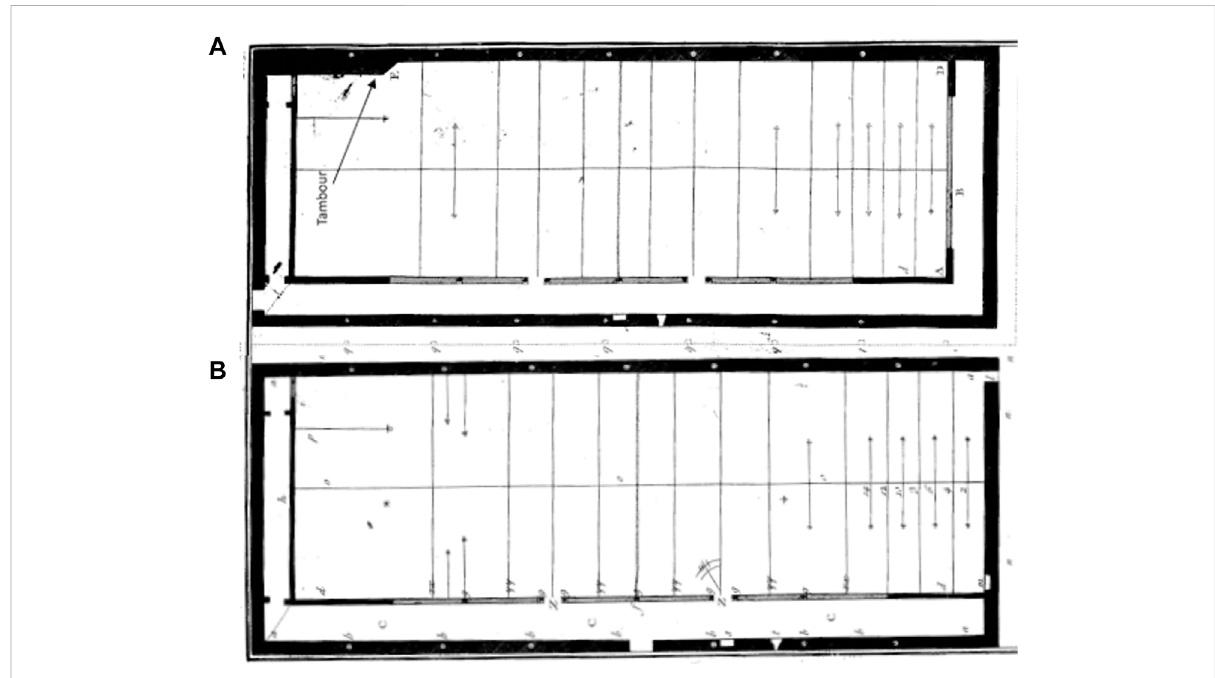
FIGURE 2 Comparison between real tennis courts: “ Dedans ” court (A) , “ Quarré ” court (B) Ferrette and Esnault, (2016).